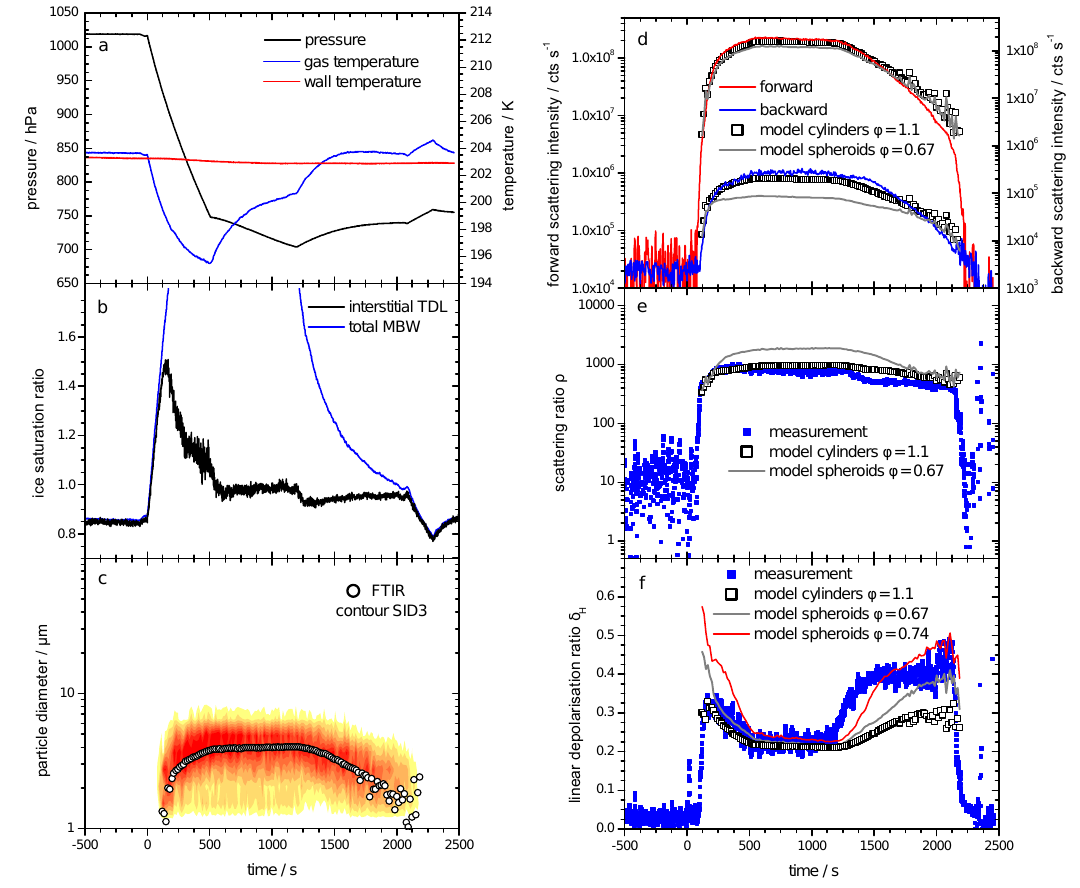
Fig. 10. As Fig. 9 but for the heterogeneous ice nucleation experiment HALO06 30.